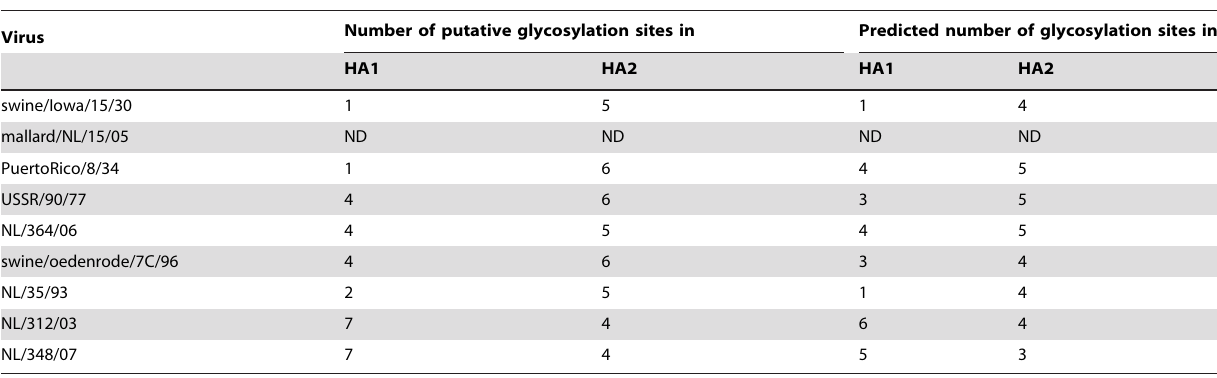
Table 1. Number of putative N linked glycosylation sites present in HA1 and in HA2 of the viruses used in this study.